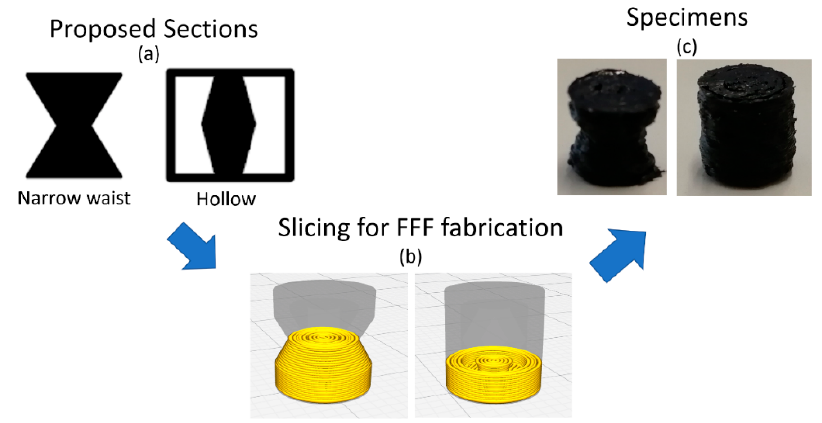
Figure 2. Principle of the 3D-printed transducer. ( a ) the sections analyzed; ( b ) the slicing stage; ( c ) the 3D printed specimens.